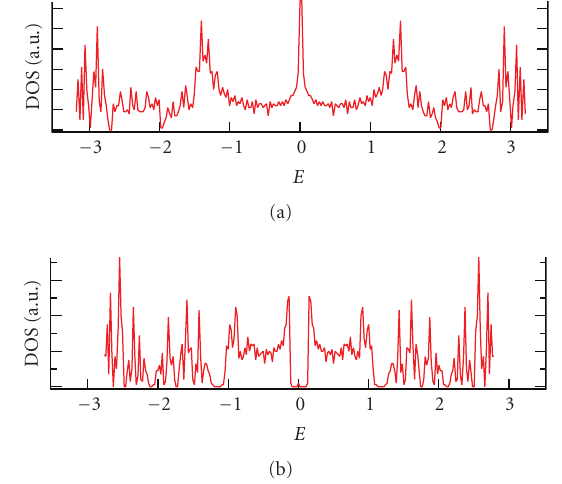
Figure 12: DOS as a function of energy for the binary disordered cases in the two-chain model. (a) W AT = 2 . 0, W GC = 1 . 0, and a = 1 . 0, b = 1 . 0. (b) W AT = 2 . 0, W GC = 1 . 0, a = 1 . 0, and b = 0 . 5. The on-site energy is set at A nn = B nn =